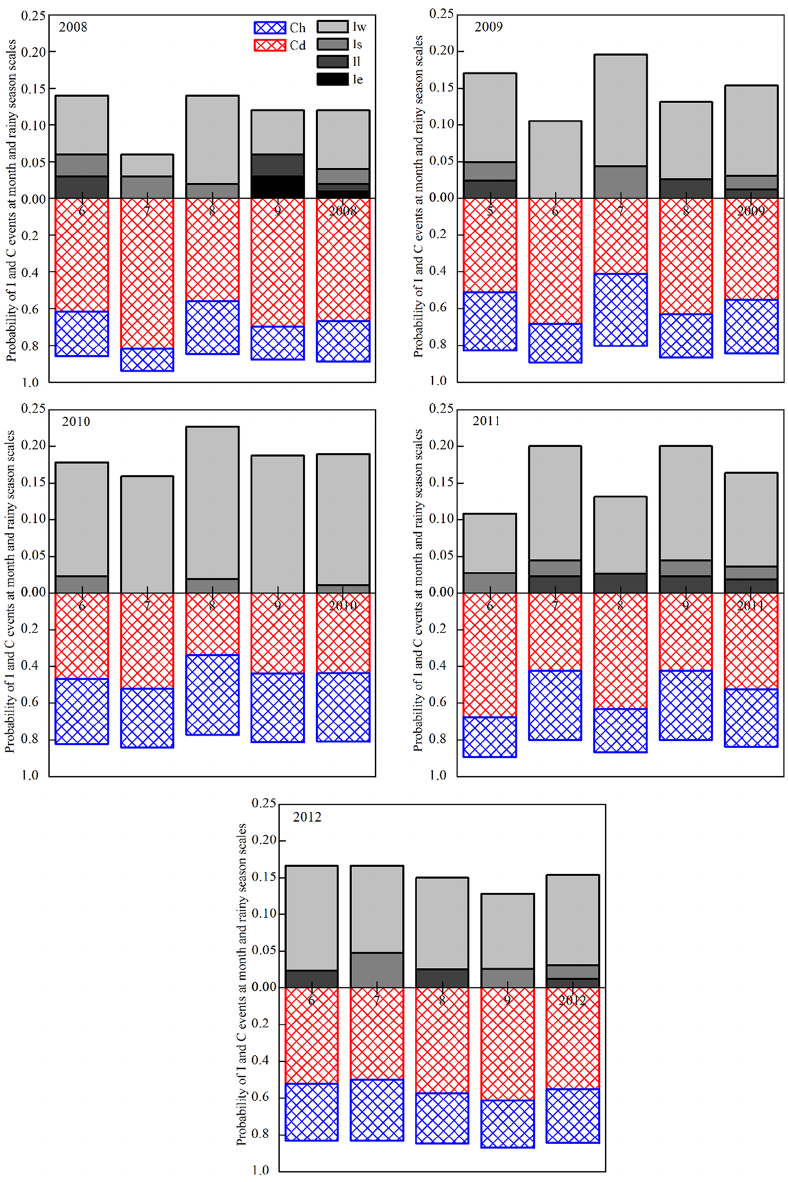
Figure 3. The probability distribution of different random rainfall event types (Iw, Is, Il and Ie) and random non-rainfall event types (Ch and Cd) at monthly and seasonal scales from the rainy seasons of 2008 to